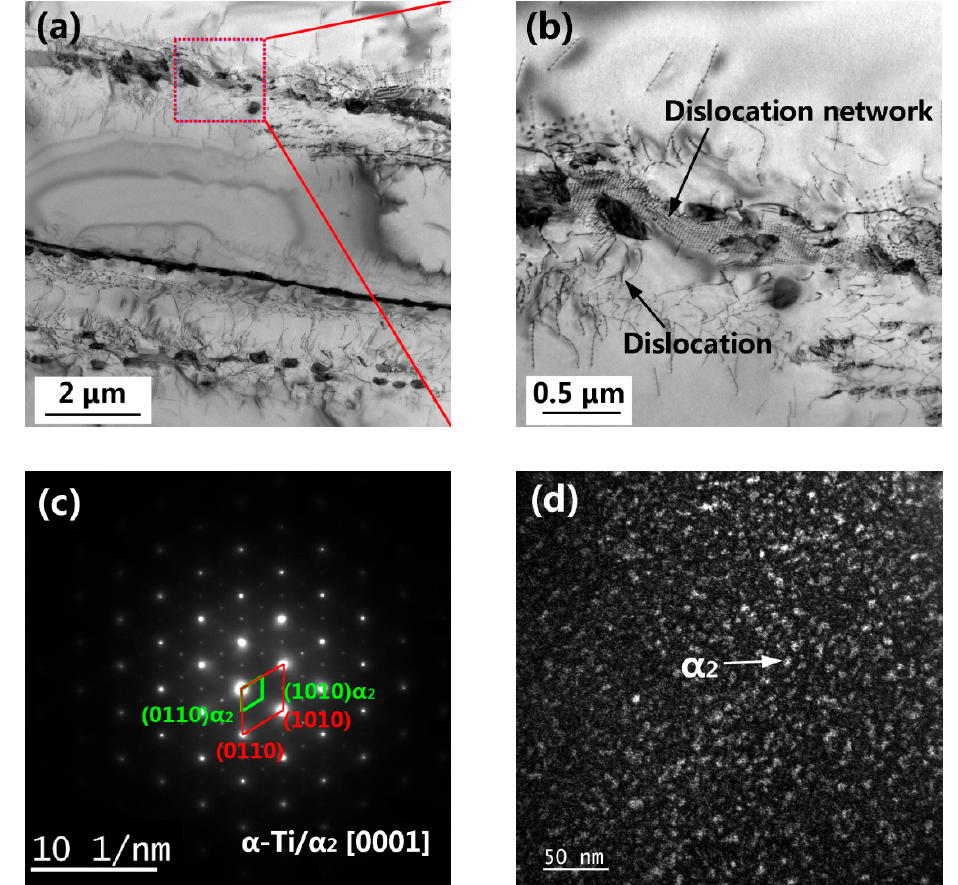
Figure 14. STEM images of the as-built specimen after the creep test ( a , b ), SADP obtained from the lamellar α phase ( c ), and dark-field TEM image of the α 2 phase ( d ).